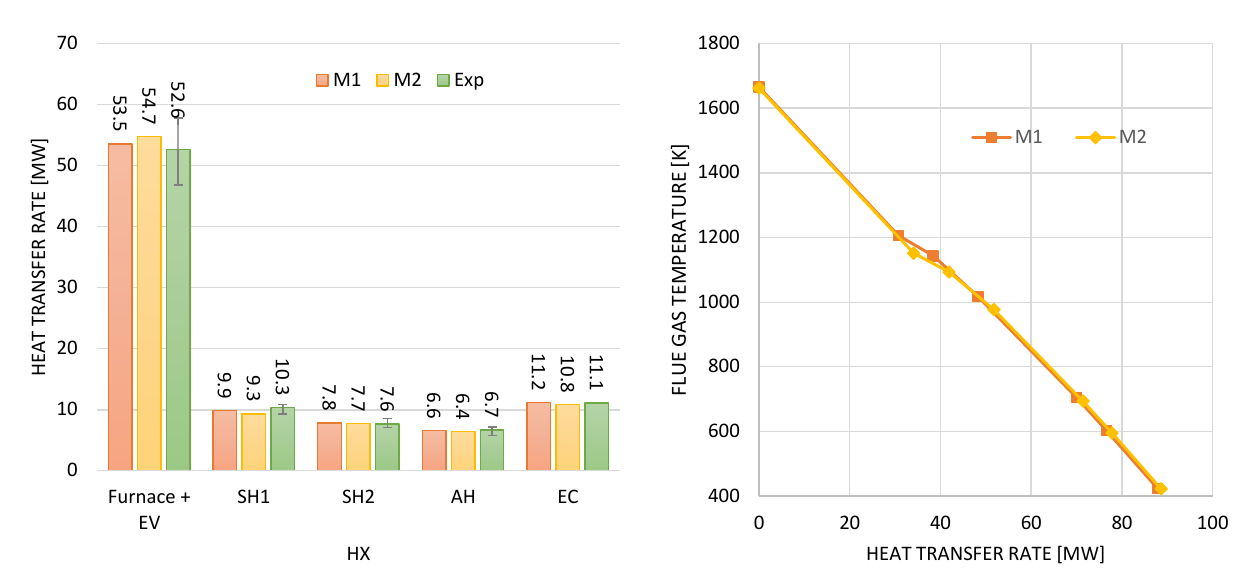
Figure 12. Calculated and measured heat transfer rates to different heat exchanger components ( left ); Q-T diagram for two modelling approaches ( right ) for industrial-scale biomass-fired boiler model.